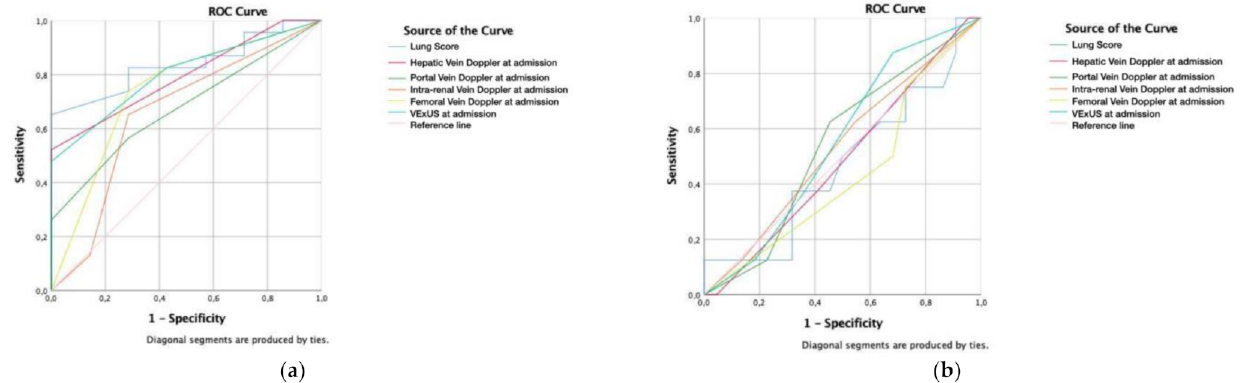
Figure 3. ( a ) Receiver operating characteristic (ROC) curve for predicting intermediate and high probability of Pulmonary Hypertension (PH) according to Lung Score (area under the curve-AUC- 83.9%; p = 0.008), VE × US score (AUC 80.1%; p = 0.017) and hepatic vein Doppler (AUC 79.5%; p = 0.020) at admission; ( b ) ROC curve for predicting the probability of creatinine worsening during hospitalization, according to lung score, VE × US score, and hepatic vein Doppler at admission, without any significant results (AUC between 47.4% to